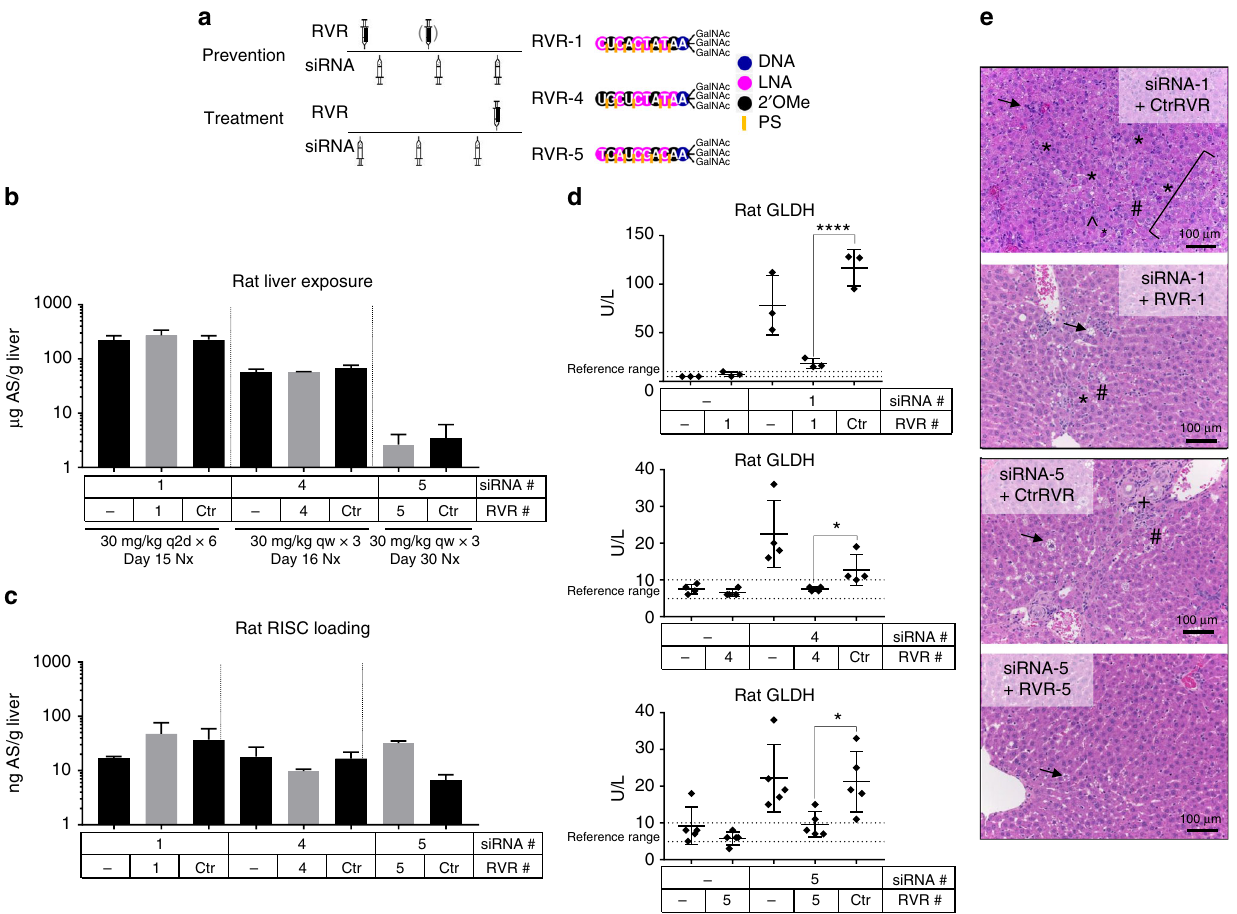
Fig. 3 Blocking antisense strand-loaded RISC activity mitigates hepatotoxicity. a Study design depicting prevention and treatment of rat toxicity by GalNAc- siRNAs using REVERSIR TM . b Liver exposures for GalNAc-siRNAs in rat prevention (siRNA-1 and siRNA-4) or treatment (siRNA-5) toxicity studies as assessed by stem-loop RT-qPCR for the antisense strand (AS) at necropsy (nx). c Liver RISC loading with or without REVERSIR TM treatment as assessed by stem-loop RT-qPCR for the antisense strand at necropsy. d Serum glutamate dehydrogenase (GLDH) levels measured at necropsy. Differences between group means were evaluated for statistical signi fi cance using one way ANOVA with post hoc corrections (for multiple siRNAs) in GraphPad Prism 7. ns. not signi fi cant; * p < 0.05; **** p < 0.0001. Error bars represent standard deviation of the mean. e H&E staining of liver sections collected at necropsy. Known toxic siRNAs administered alone or with a scrambled, control (Ctr) REVERSIR TM were associated with hepatocellular degeneration (bracket), single cell necrosis (*), increased sinusoidal cells consistent with Kupffer cell hyperplasia and/or in fi ltrating leukocytes (#), increased mitoses (^), bile duct hyperplasia with fi brosis (+), and hepatocellular vacuolation (arrow). Co-administration of a complementary REVERSIR TM decreased the severity of these fi ndings and often limited their distribution. All microscopic liver fi ndings are tabulated in Supplementary Table 5. N = 3 males (6 – 8 weeks old) per group; qw, weekly dosing; q2d, every other day elevations observed with their respective targets, siRNA-1,